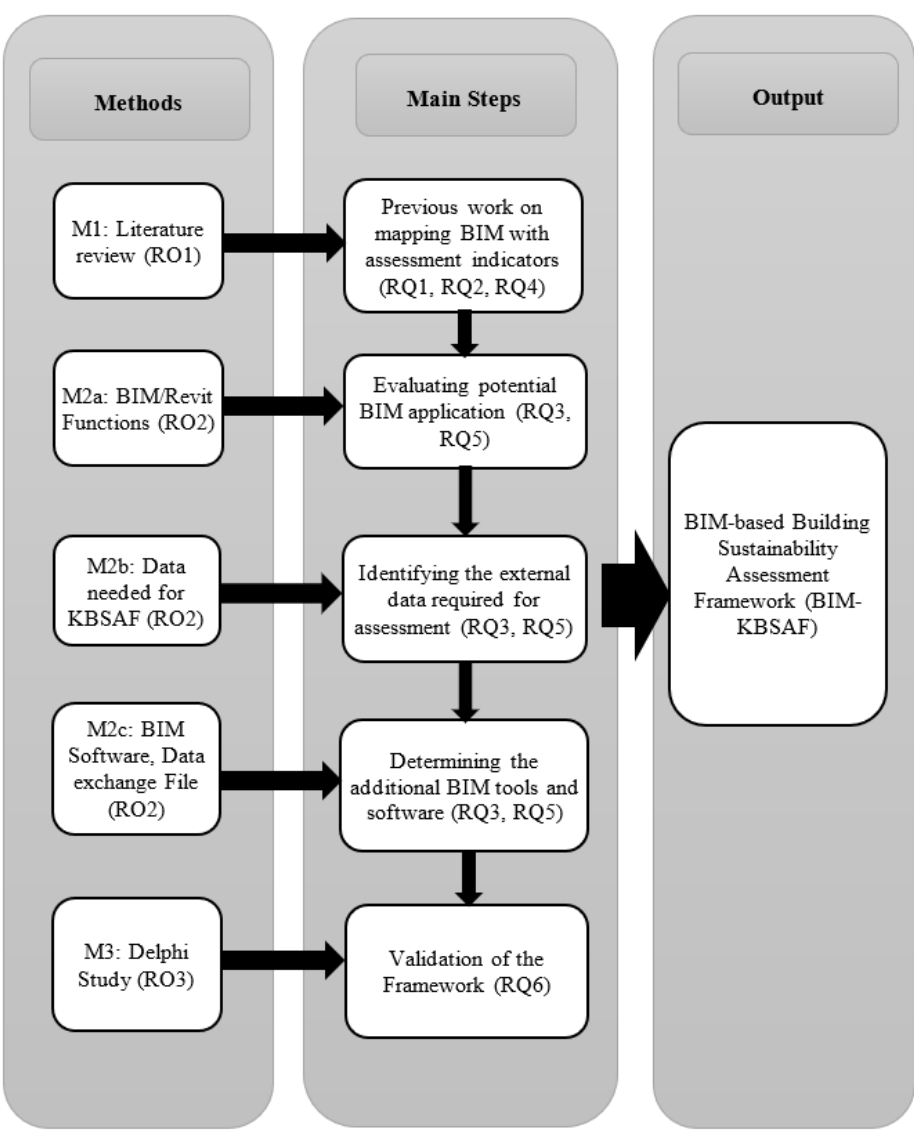
Figure 1. Flowchart of Research Methodology.